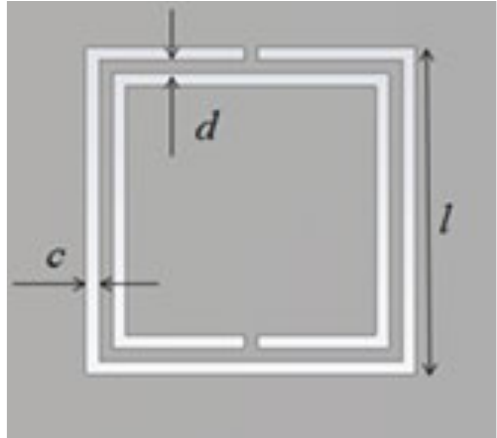
Figure 4. SCSRR main dimensions.